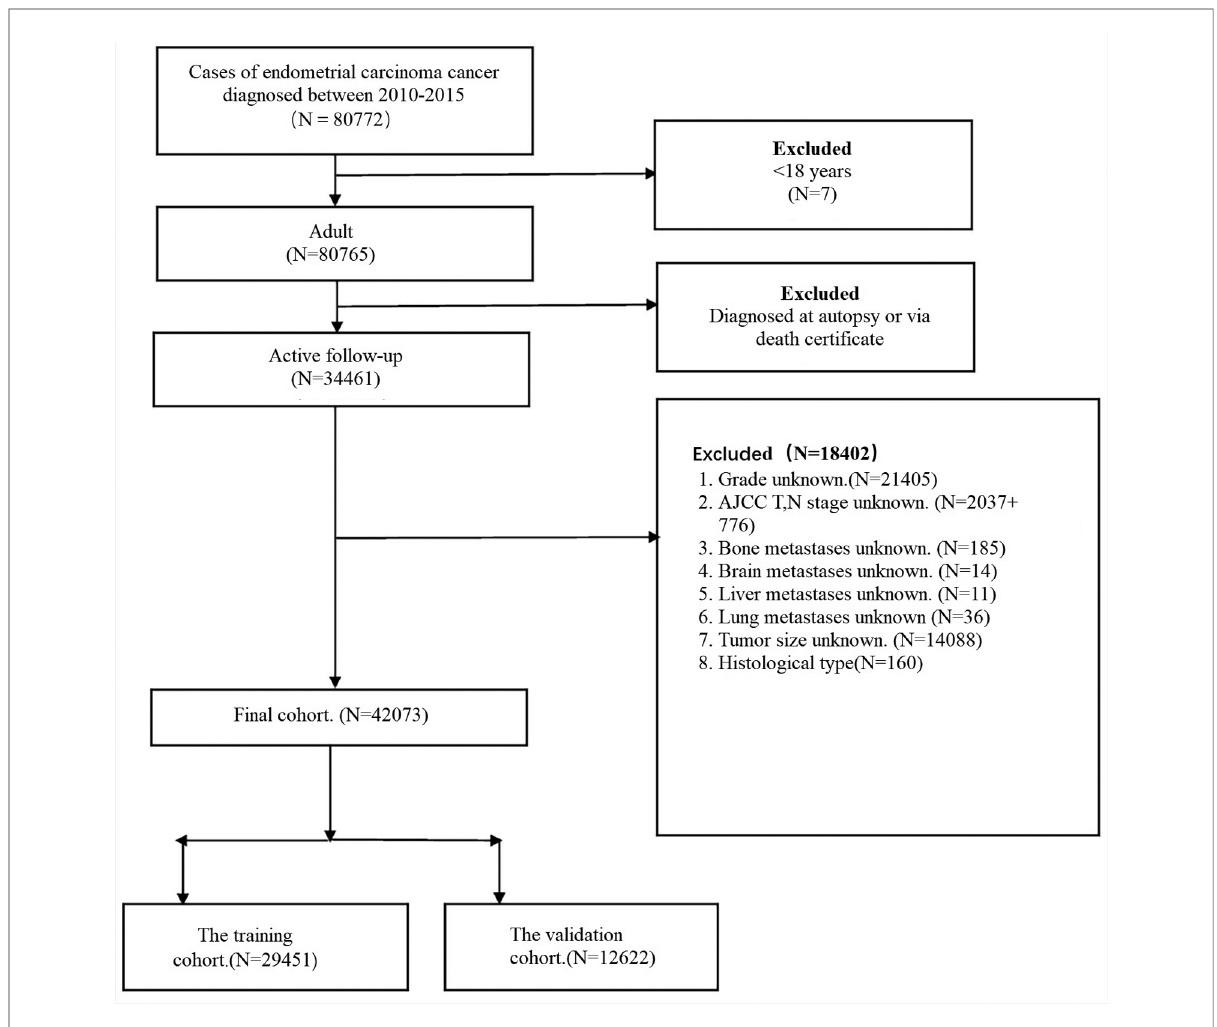
FIGURE 1 The fl owchart of patient